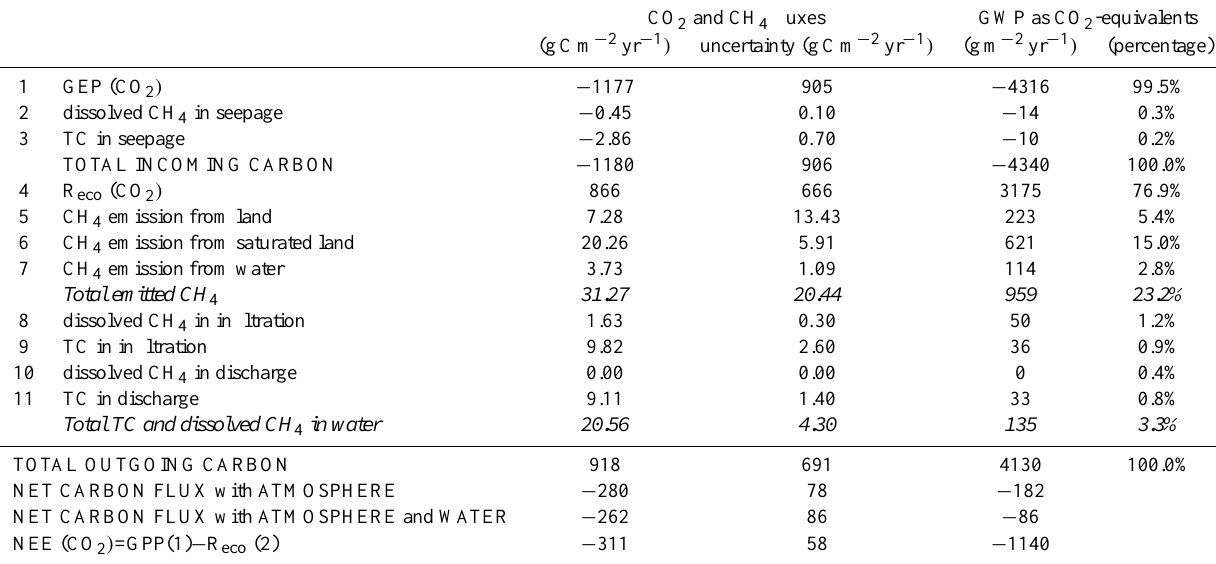
Table 10. Summary of all carbon fluxes in the research area over 2005. Fluxes are presented in g C, CO 2 -equivalents and percentage of CO 2